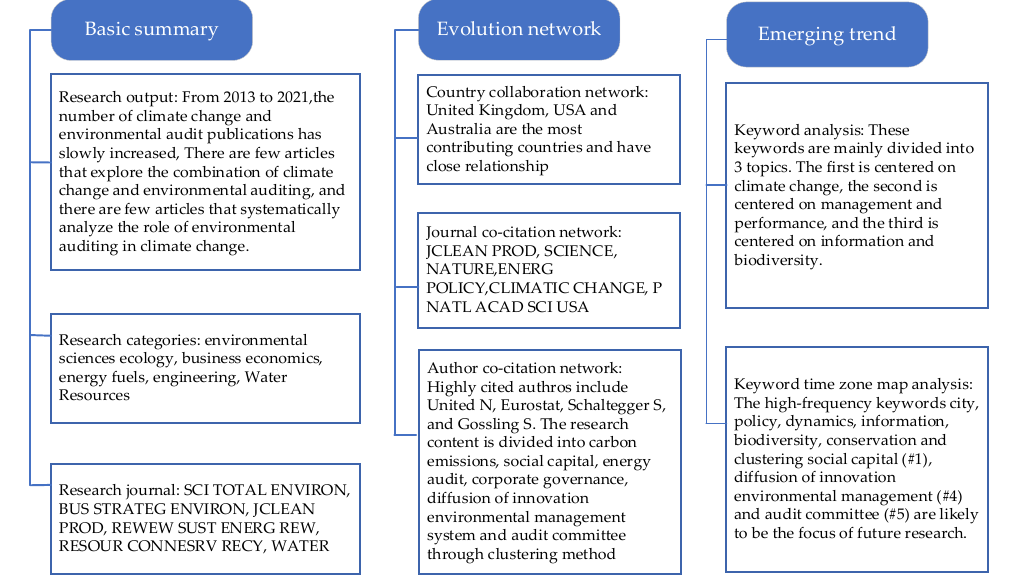
Figure 11. Article structure framework.